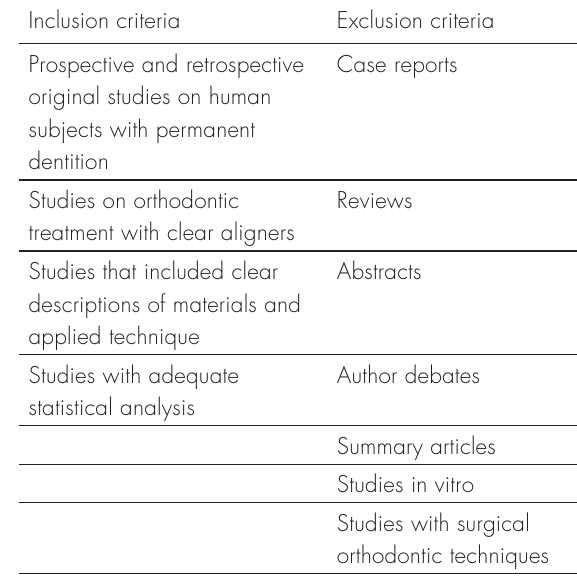
Table II. Inclusion and exclusion